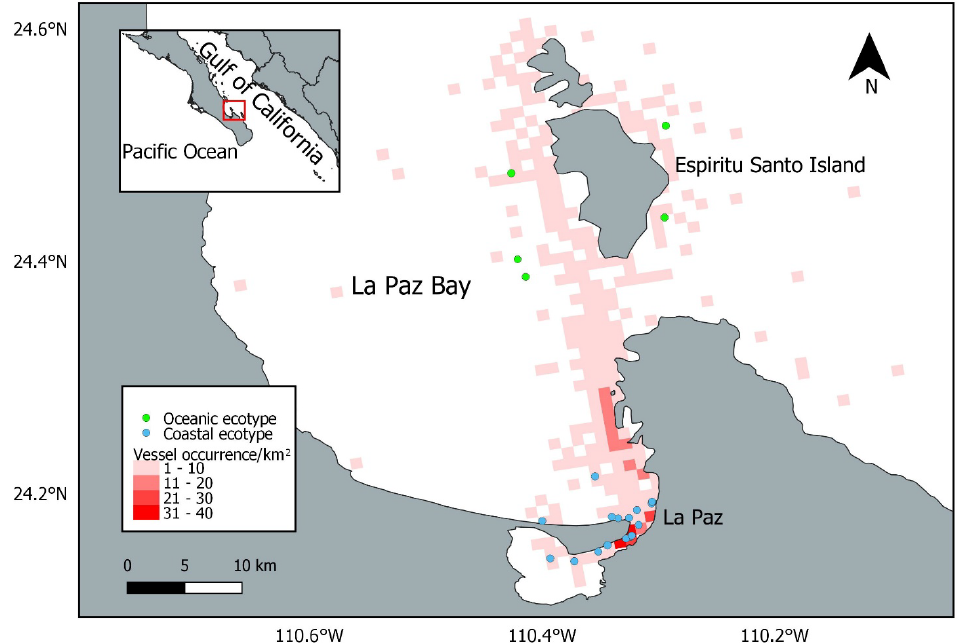
Figure 1. Location of the common bottlenose dolphin groups recorded (coastal groups, n = 16; oceanic groups, n = 5) and vessel occurrence. Basemap shapefile provided by Comisión Nacional para el Conocimiento y Uso de la Biodiversidad When a sighting occurred, the research vessel tracked parallel to the course of mov- ing dolphins, approaching slightly to the rear of the group in a slow and continuous ma- neuver. At this point, the engine was turned off, remaining so during all the recording duration, and the hydrophone carefully deployed (4 m cable length). When the sea depth was less than 4 m, a length of the cable equal to the half of the sea depth was deployed. Sea depth was measured at the beginning of each recording session using a digital depth gauge HONDEX (PS-7). In case the dolphins were not visible or audible with the hydro- phone, the engine was turned on and the group was carefully followed to attempt another recording session (for a maximum of 3 attempts). Acoustic data were collected using a Reson TC4013.1 hydrophone (sensitivity − 211 dB RMS ± 3 dB re 1 V/μPa, frequency response 1 Hz to 170 kHz, omnidirectional) connected through a Reson VP2000 Voltage Preampli- fier EC6081 (50 dB gain, 500 Hz high-pass filter, 50 kHz low-pass filter) to a Marantz PMD661 recorder (sampling rate 96 kHz, 24 bits resolution). For each recording session the ecotype and number of dolphins were noted. Due to the difficulty of determining which individuals were being recorded, all visible dolphins were counted and considered as one ‘acoustic’ group. Common bottlenose dolphin eco- types were determined by naked eye observations, according to the specific morphologi- cal characteristics previously reported in the study area [22,26,29]. No mixed groups were encountered. Recordings were conducted as long as dolphins were visible. During the observation time, on occasion, vessels approached the group of dolphins, so separate